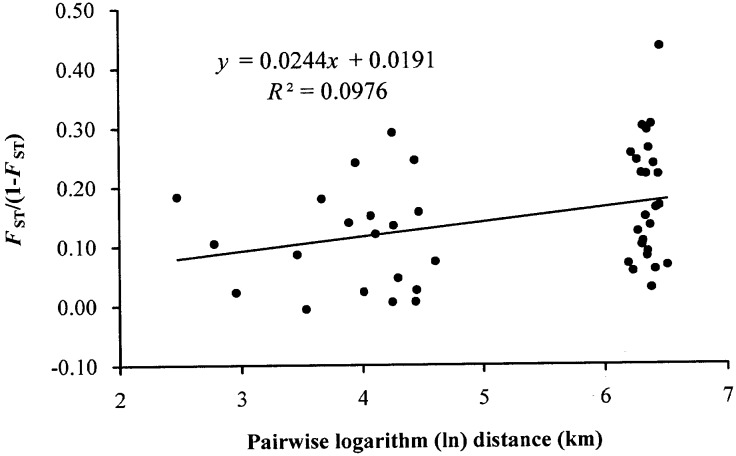
Differentiation between populations of Lilium cernuum.Multilocus estimates of pairwise differentiation of FST/(1 − FST) are plotted against logarithm (ln) of pairwise geographic distances in meters. A significant relationship was found for L. cernuum (r = 0.312, P = 0.041).